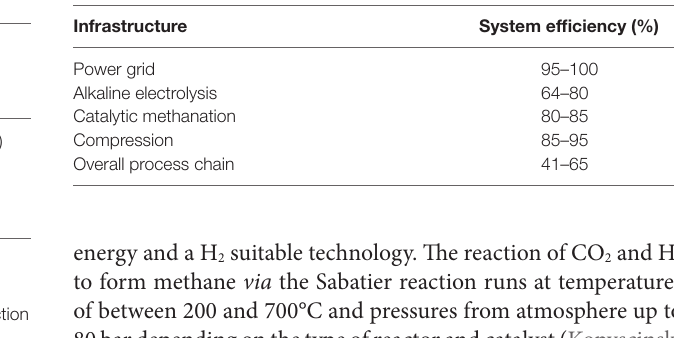
TaBle 3 | Typical efficiency values and chain efficiency of the overall power-to- gas processes by provision of solar electricity according to Stolten and Krieg (2010) and Schnurbein (2012).